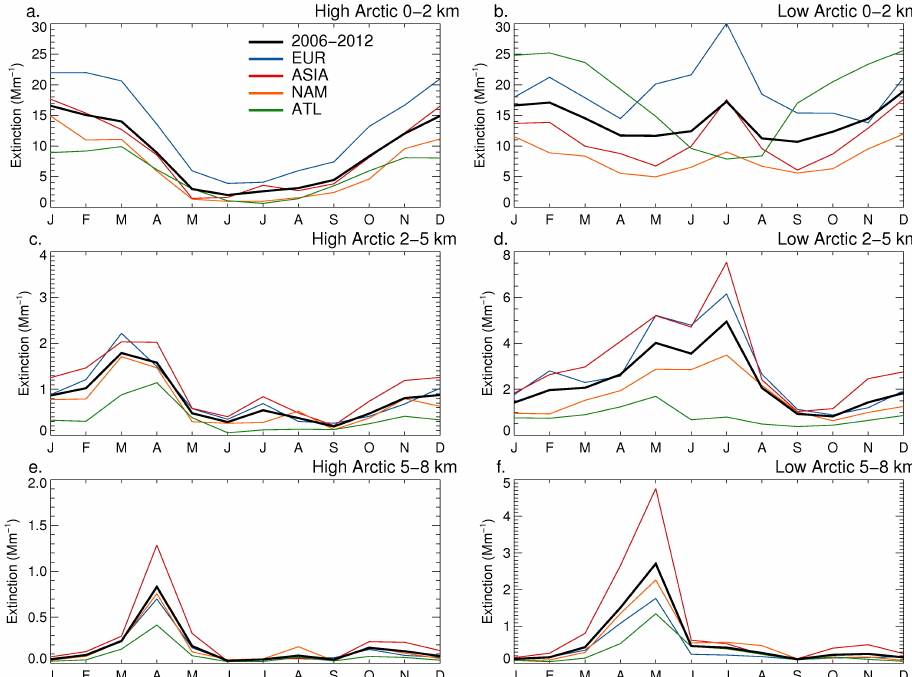
Fig. 9. Seasonal cycle of monthly CALIOP aerosol nighttime-equivalent extinction at 0–2km (top panels), 2–5km (middle panels) and 5– 8km (bottom panels) averaged over 2006–2012. Left panels (a, c, e) are for the High Arctic (59 ◦ –69 ◦ N); panels on the right (b, d, f) are for the Low Arctic (69 ◦ –82 ◦ N). The black line corresponds to the mean extinction for the entire High and Low Arctic regions, while colored lines are for the individual Arctic sectors defined in Fig.